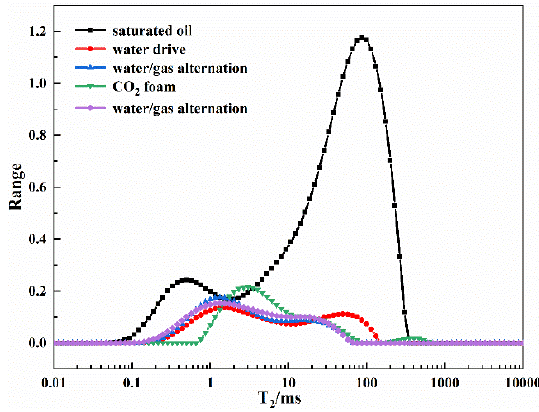
Figure 8. NMR T 2 spectra of different flow control systems in core No. 3.